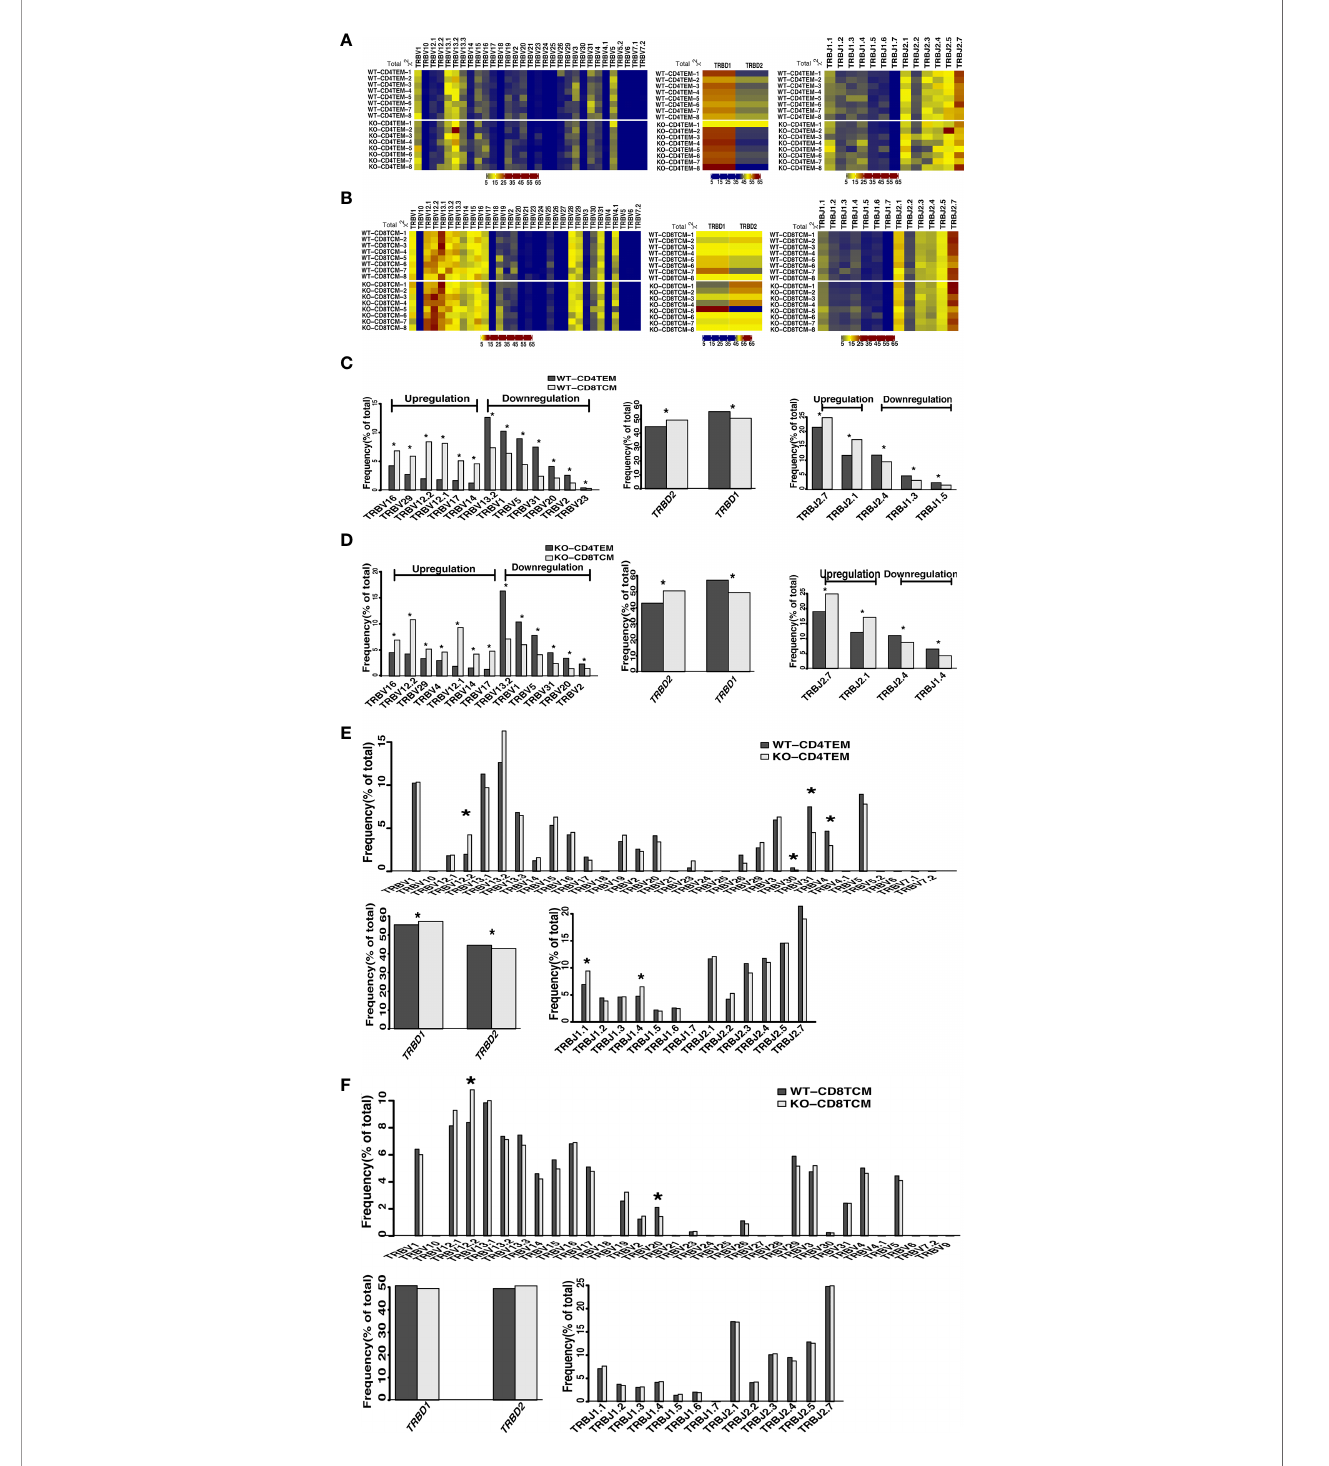
FIGURE 2 | Differential usage of V, D and J genes in the total sequences of TRB repertoires of CD4 + TEM cells and CD8 + TCM cells in WT and KO chimeras. Heatmap represents V, D and J gene usage frequency for total TRB sequences of CD4 + TEM cells (A) and CD8 + TCM cells (B) in WT and KO chimeras. Relative frequency for the usage of TRBV, TRBD, and TRBJ gene segments for CD4 + TEM cells vs CD8 + TCM cells in WT chimeras (C) , CD4 + TEM cells vs CD8 + TCM cells in KO chimeras (D) , WT vs KO chimeras in CD4 + TEM cells (E) and WT vs KO chimeras in CD8 + TCM cells (F) . *p <